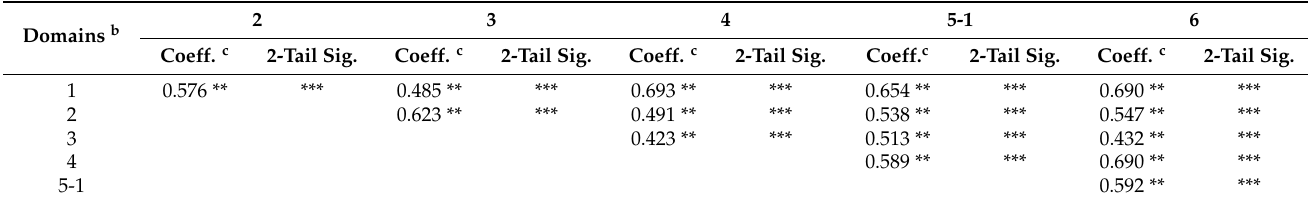
Table 3. Pearson correlation matrix of the WHODAS 2.0 domains ( n = 9886) a .